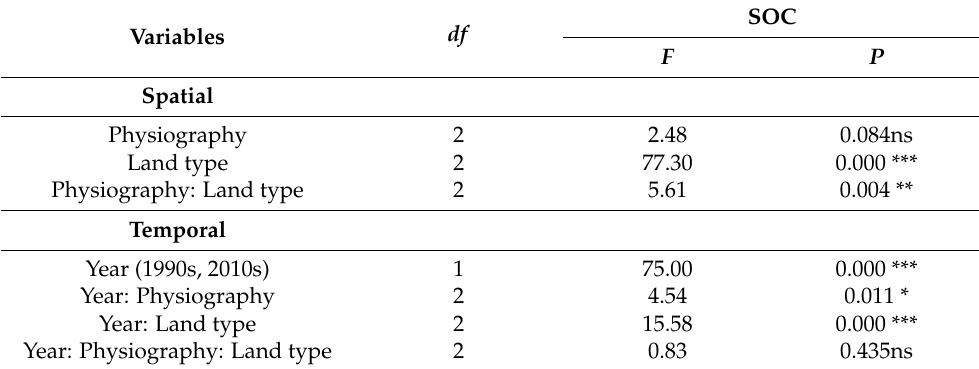
Table 1. Three-way partial factorial model for the main and interactive effects of year, physiography and land type on SOC contents between two data collection periods: 1990s and 2010s.